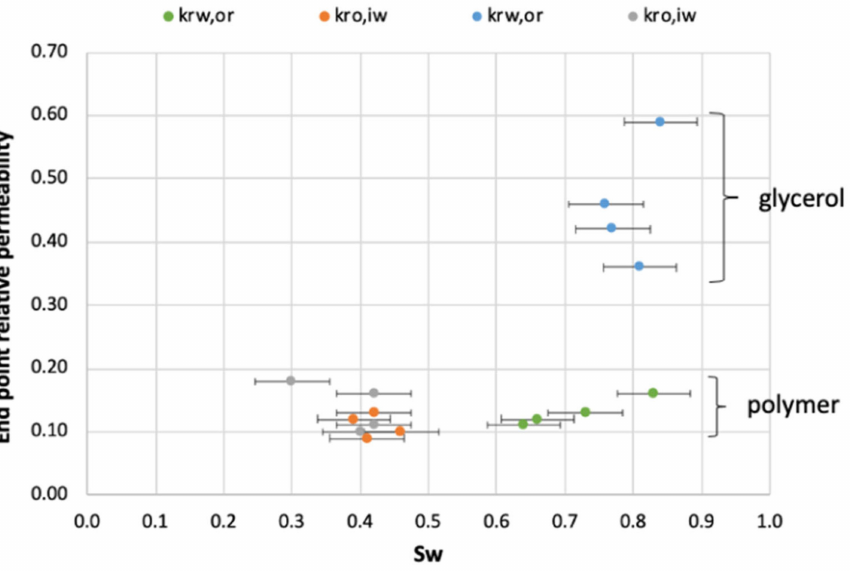
Figure 10. End-point relative permeabilities as a function of aqueous phase saturation (S w